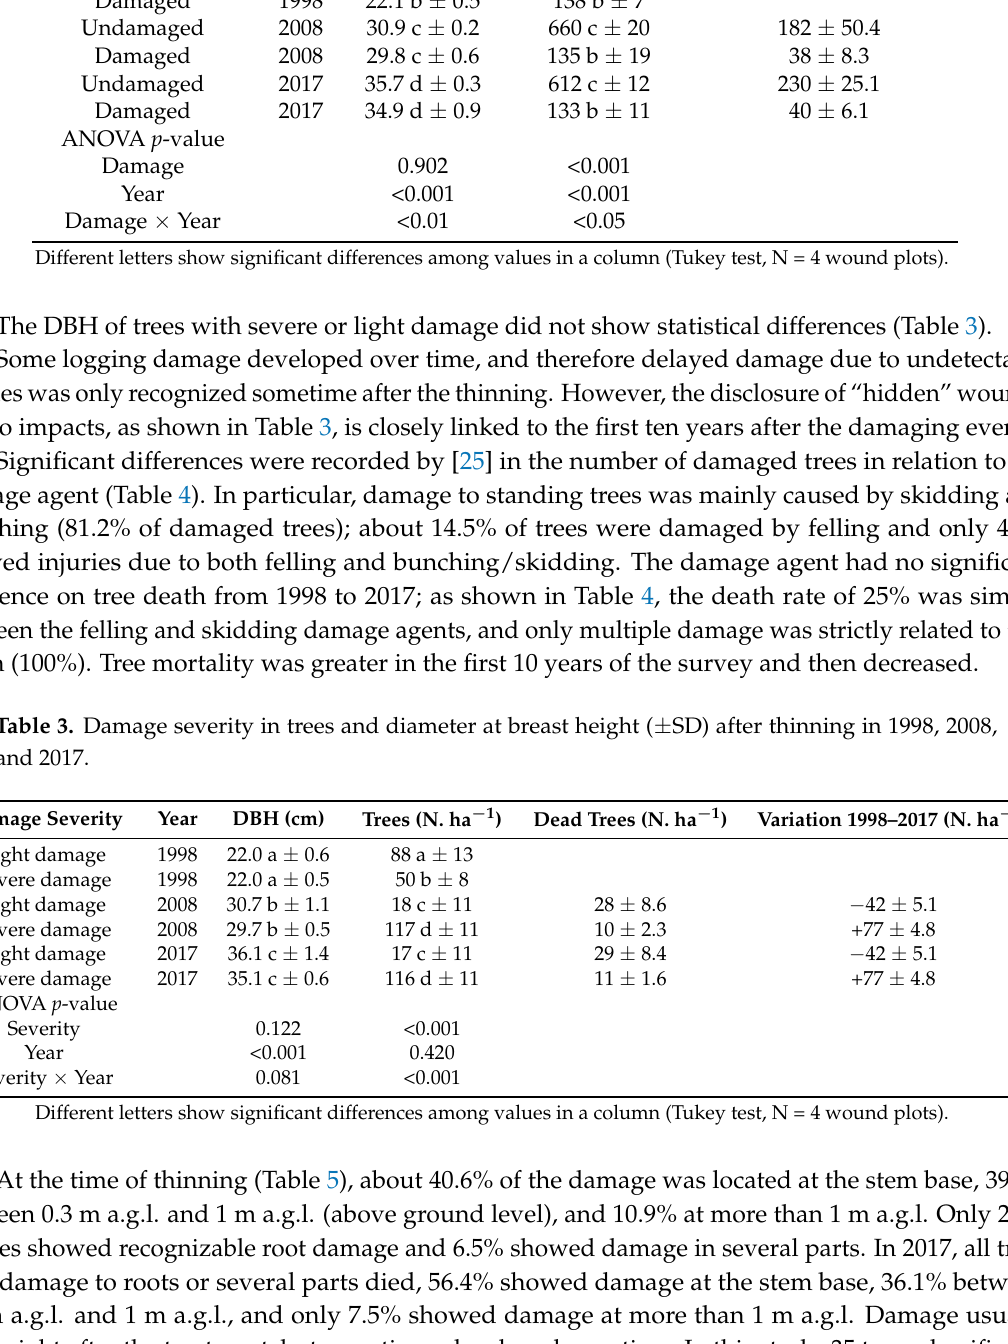
Table 2. Damage to trees and diameter at breast height ( ± SD) after thinning in 1998, 2008, and 2017. Tree Condition Year DBH (cm) Trees (N. ha − 1 ) Dead Trees (N. ha − 1 ) Undamaged 1998 20.8 a ± 0.1 877 a ± 30 Damaged 1998 22.1 b ± 0.5 30.9 c ± 0.2 182 ± 50.4